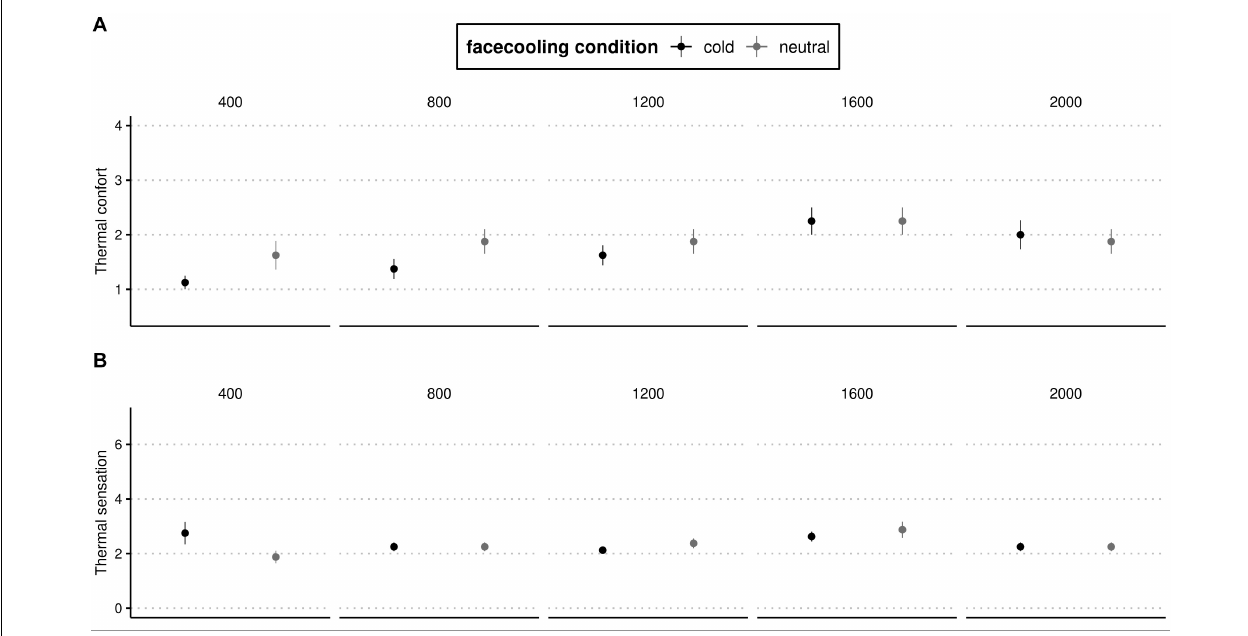
Frontiers in Psychology |